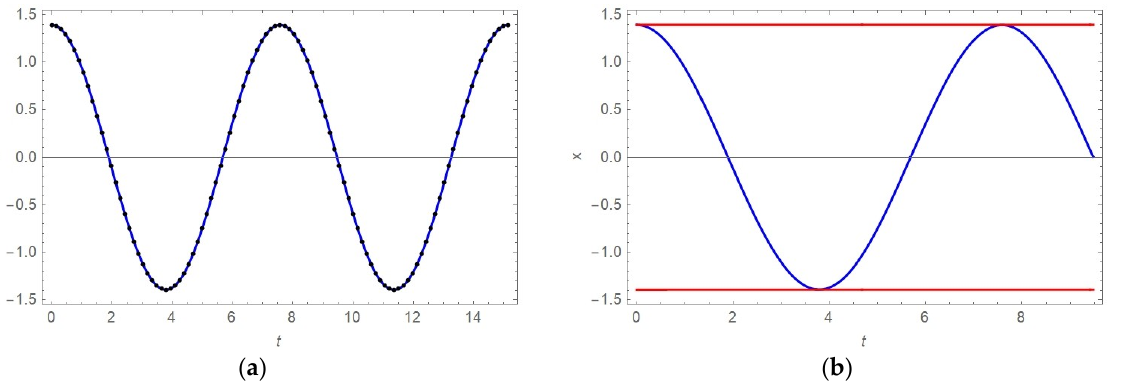
Figure 8. ( a ) x-t diagrams obtained numerically (full line) and analytically (dotted line) for k = 5.5 = const. and ( b ) x-t diagram obtained numerically (blue line) and A-t diagram obtained analytically (red line) for k ( τ ) according to (40).